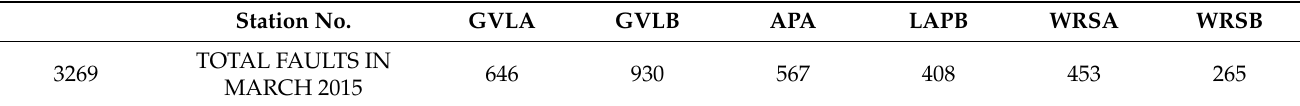
Figure 16. RIMS stations and their respective loss-of-lock start times and durations in minutes.